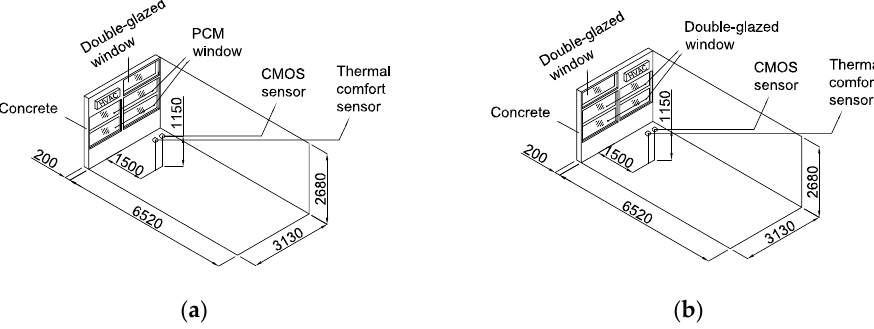
Figure 1. Office dimensions (mm). ( a ) Room with PCM glazing (main); ( b ) Room with a double-glazed window (reference). Table 1. Thermophysical properties of the PCM window and double-glazed window.